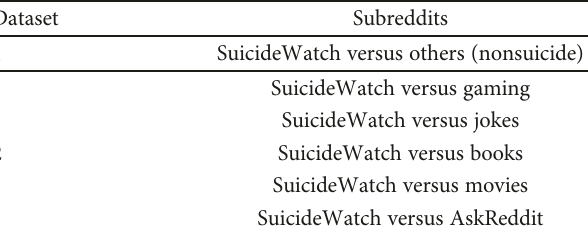
Table 2: Two balanced Reddit